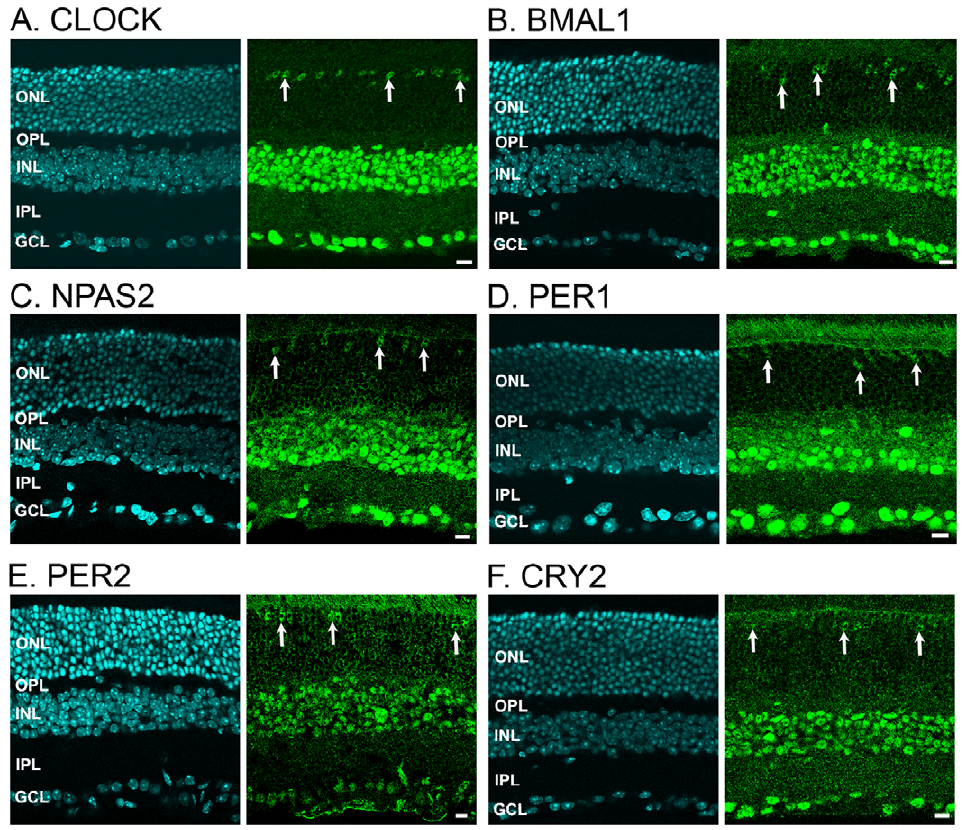
Figure 1. Distribution of six core mammalian circadian clock proteins in the mouse retina. Typical examples of vertical sections of C57Bl/6 mouse retinas collected in the middle of the day during a LD cycle (ZT02-06) are illustrated for CLOCK ( A ), BMAL1 ( B ), NPAS2 ( C ), PER1 ( D ), PER2 ( E ), and CRY2 ( F ). Expression of each clock protein is clearly prominent in the inner nuclear layer (INL) and most cells in the ganglion cell layer (GCL). However, expression is also detected in few cells in the outer nuclear layer (ONL) (vertical arrows). These cells were later identified as cones. OPL: